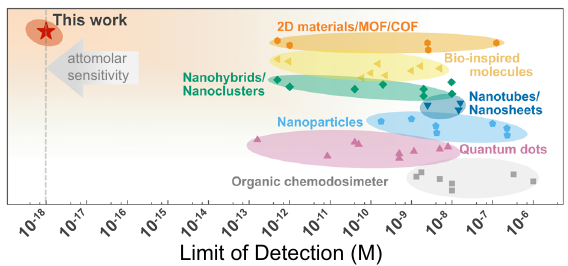
Fig. 5 Limit of detection comparison. Overview of the Hg 2 + detection limit by using different sensor materials (Supplementary refs. 11 –